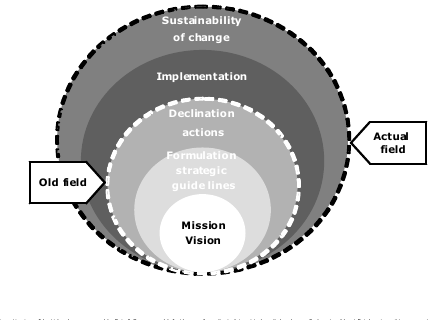
Figure 1 : Evolution of the Intervention Field of the Italian Management